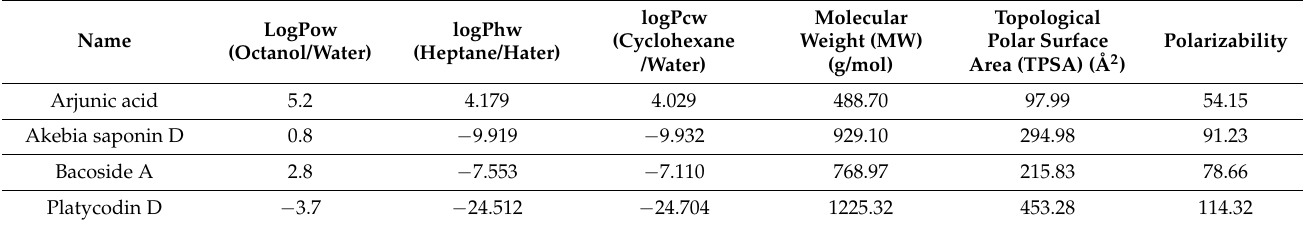
Table 4. The chosen physicochemical parameters determined for the tested